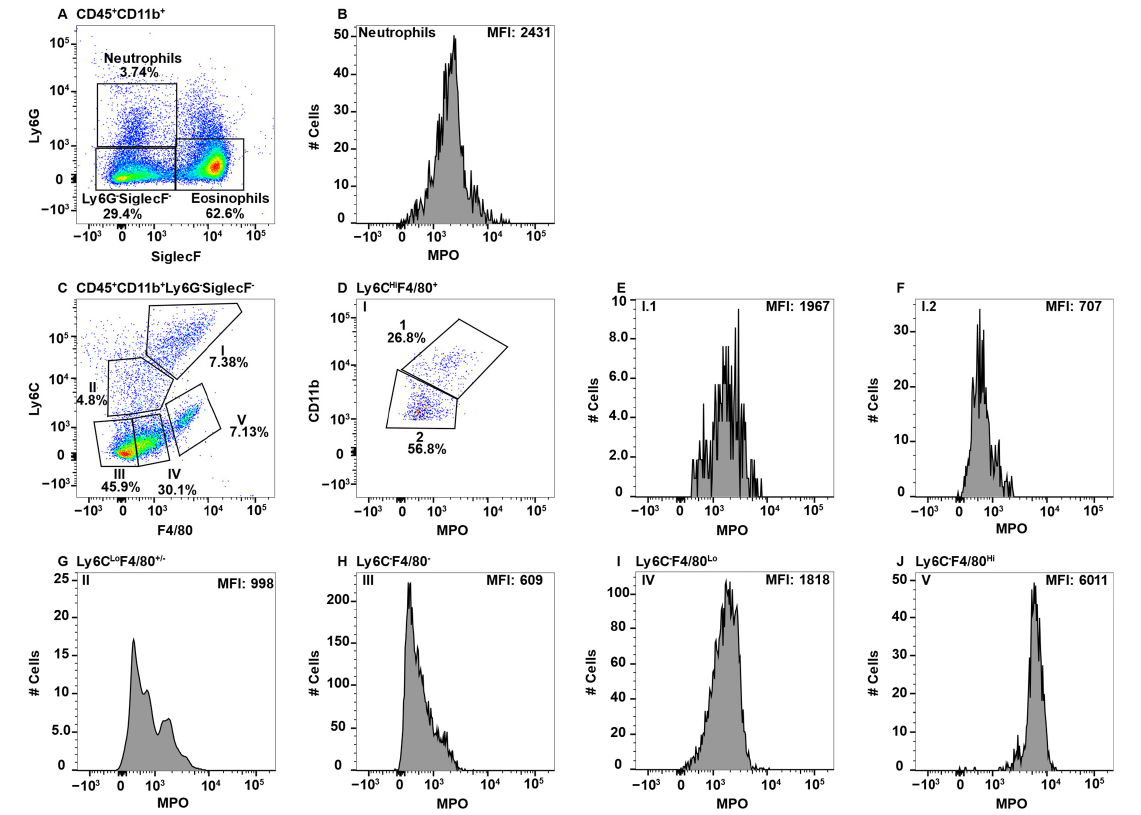
Figure 6. Small intestinal macrophage subsets differentially express MPO. Small intestine mononu- clear cells were stained with antibodies specific for CD45, CD11b, Ly6C, Ly6G, F4/80, MPO, and SiglecF and using flow cytometry, CD45 + CD11b + cells were analyzed for Ly6G and SiglecF expression to identify Ly6G + SiglecF − neutrophils and Ly6G − SiglecF + eosinophils ( A ). Neutrophil MPO-positive staining is shown ( B ). CD11b Hi Ly6G − SiglecF − cells were analyzed for F4/80 and Ly6C expres- sion and five Subpop (I–V) were identified ( C ). Subpop I F4/80 + Ly6C Hi cells were separated into CD11b Hi (1) and CD11b Lo (2) populations ( D ), and MPO expression is shown ( E and F , respectively). MPO expression in Subpop II Ly6C Lo F4/80 + ( G ), III Ly6C − F4/80 − ( H ), IV Ly6C − F4/80 + ( I ), and Ly6C − F4/80 Hi V ( J ) is shown. The percent positive cells in dot plot gates and the MFI of histograms is provided. Data shown are representative of three